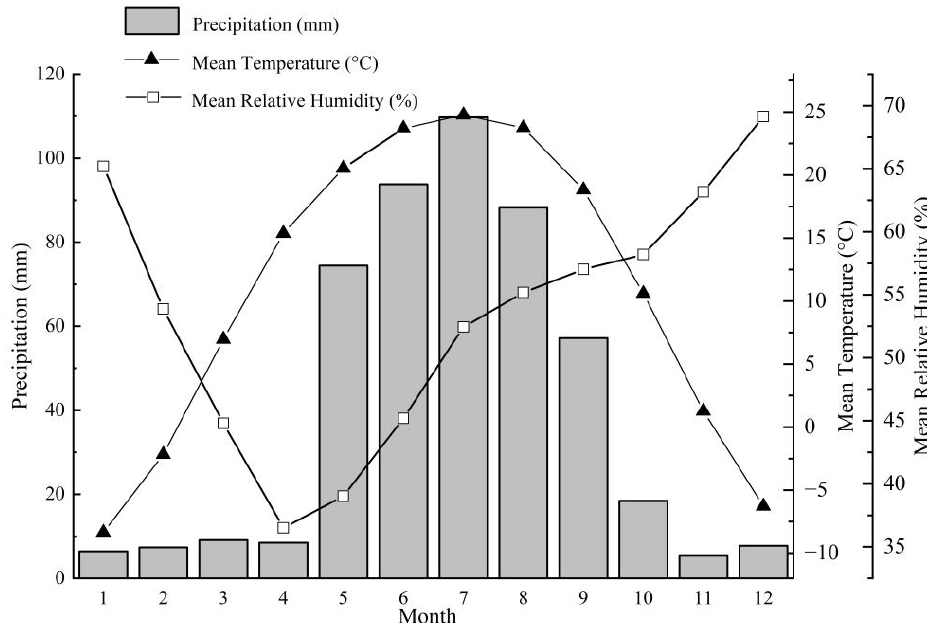
Figure 2. Distribution of temperature, precipitation, and relative humidity as monthly averages for meteorological stations in Alaer from 1959 to 2018.